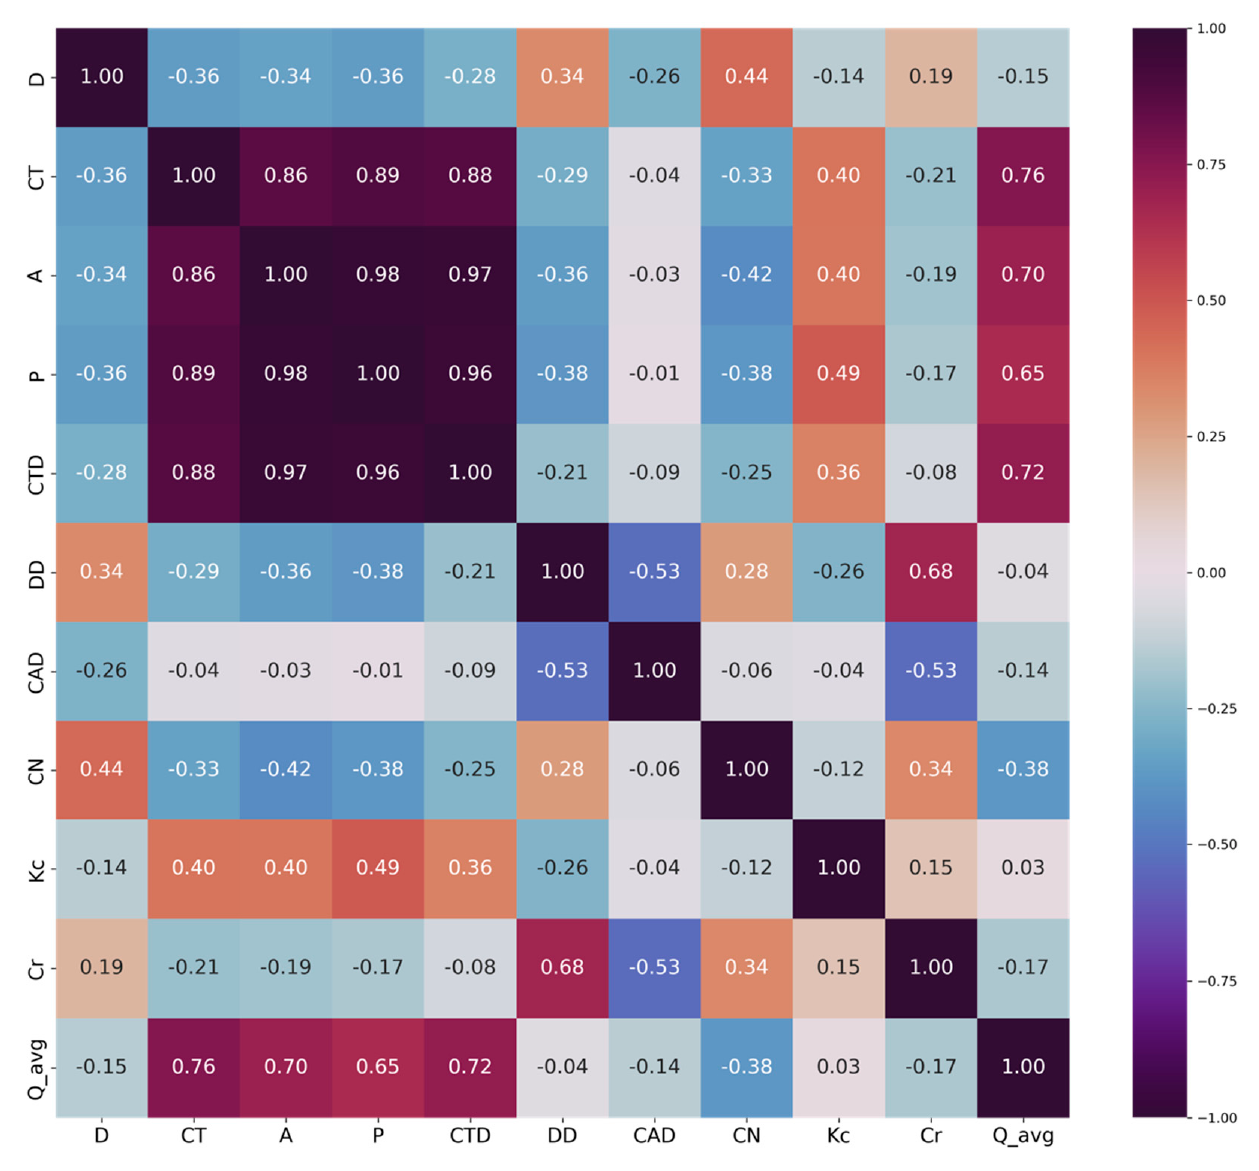
Figure 6. Features Pearson correlation coefficient heatmap.